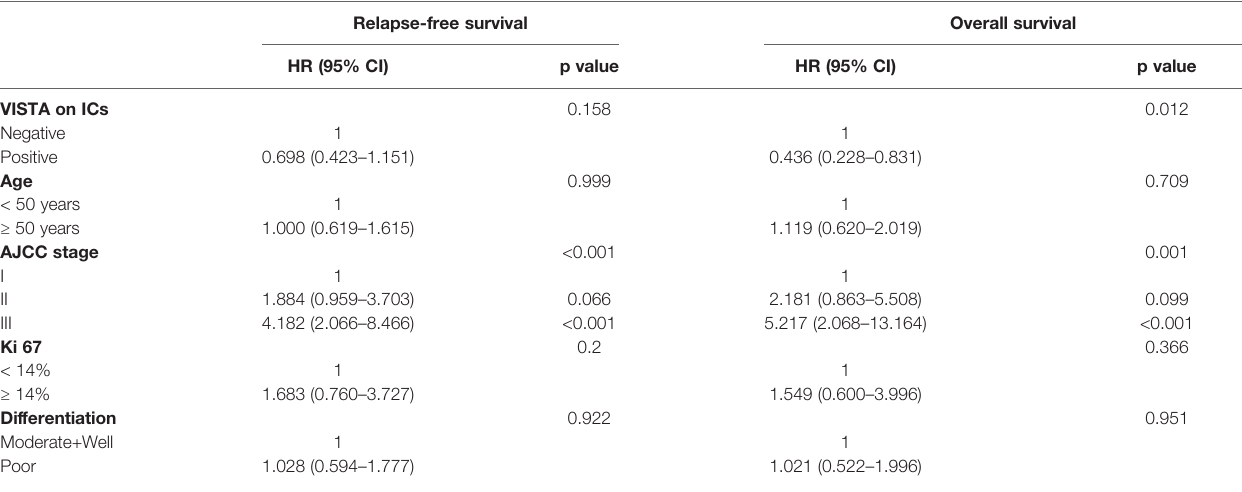
TABLE 3 | Multivariate analysis for patients with